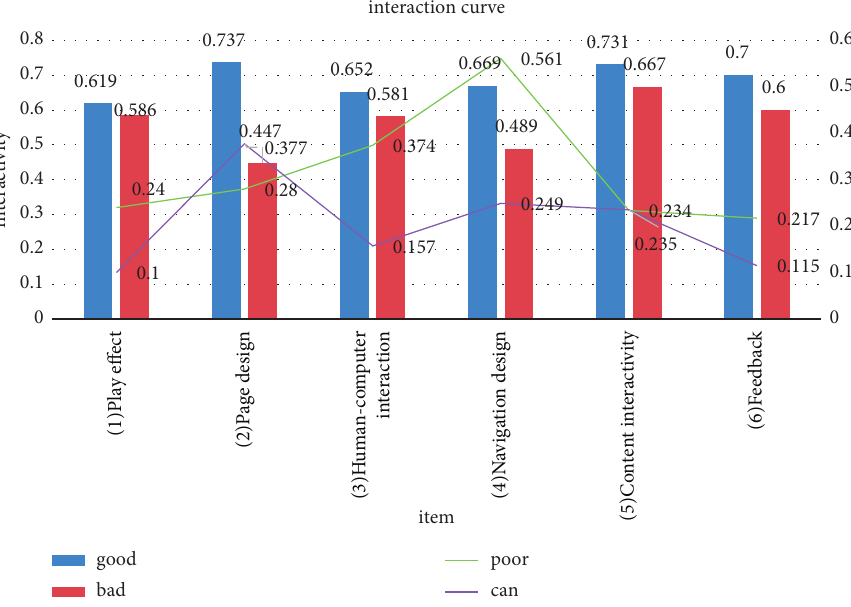
Figure 3: Interactive curve of online